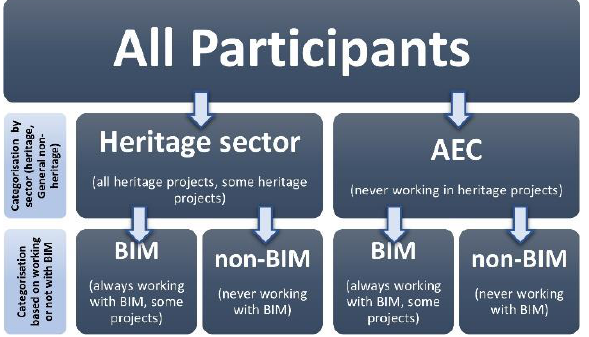
Figure 1: Categorisation of questionnaires participants.